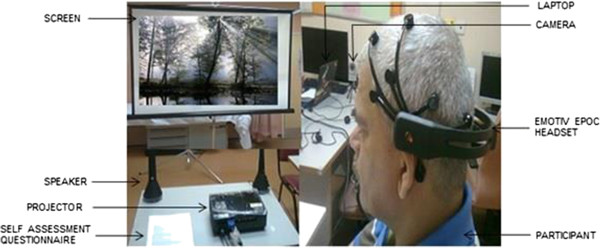
Experimental setup.